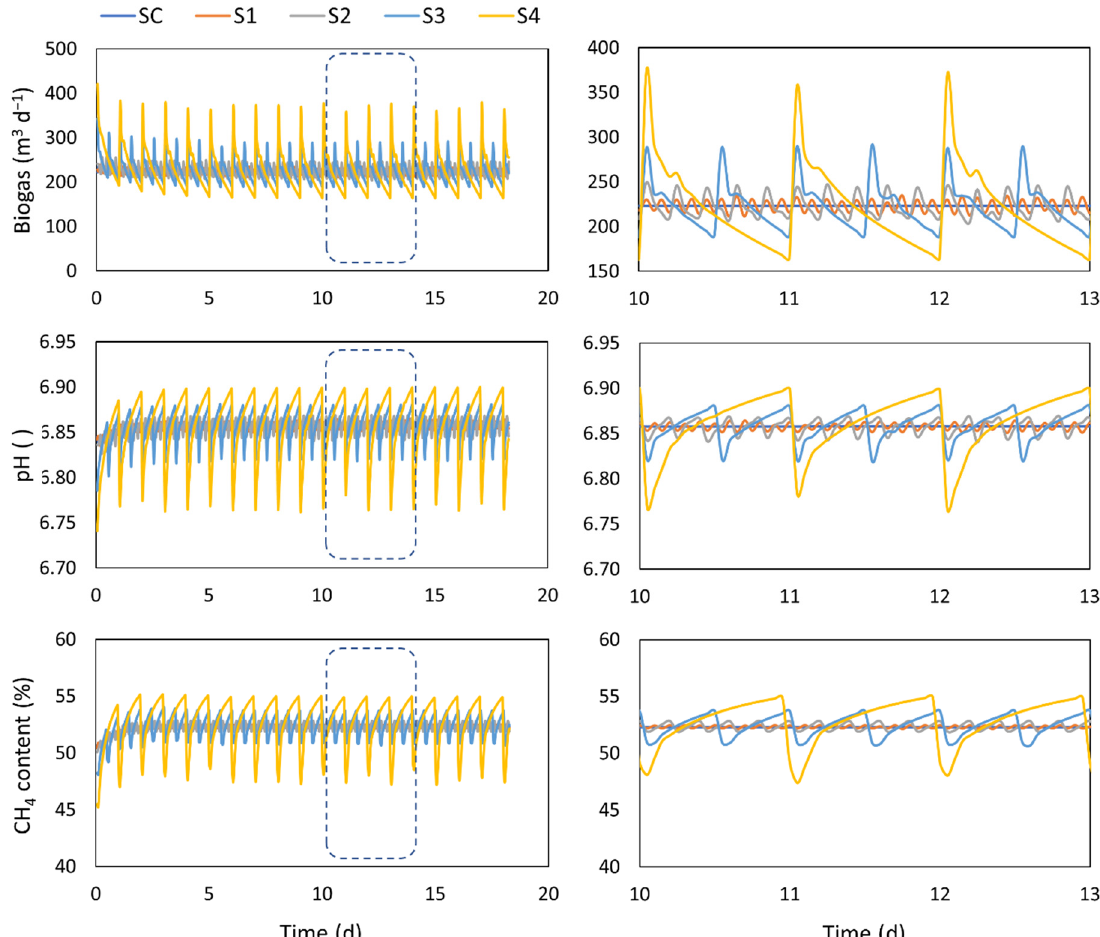
Figure 1. Performance of a digester under different feeding strategies. Left : results of 18 days of operation. Right : zoom in on only 3 days of operation.